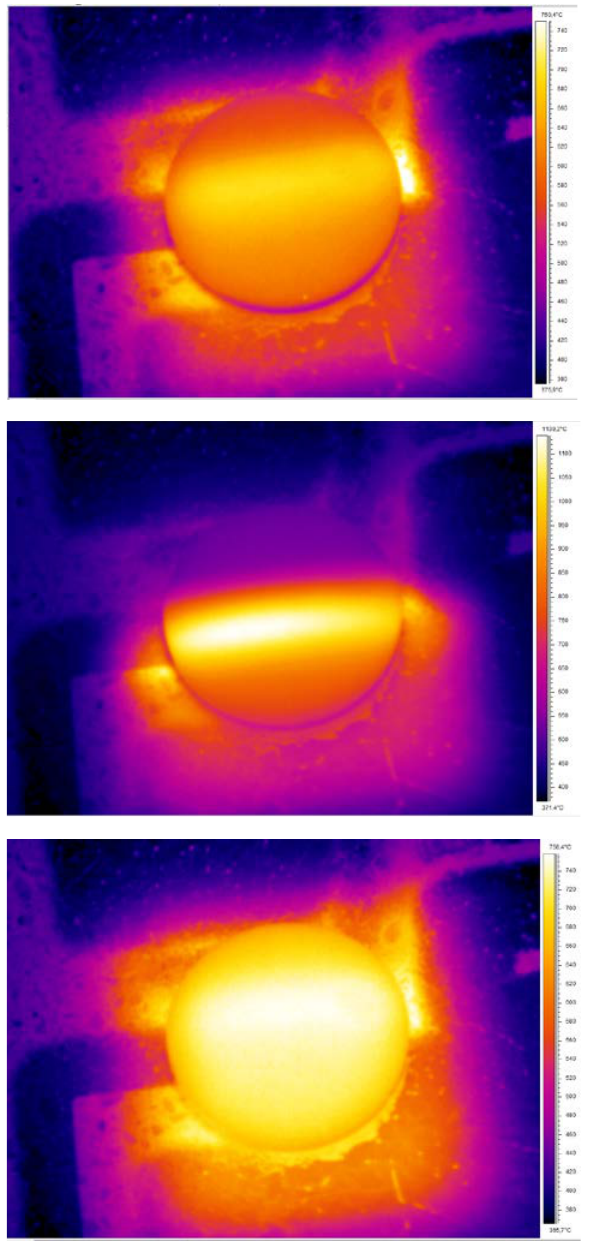
Fig. 5. Thermographic images during the three phases. a) preheating, b) laser beam polishing and c) postheating.